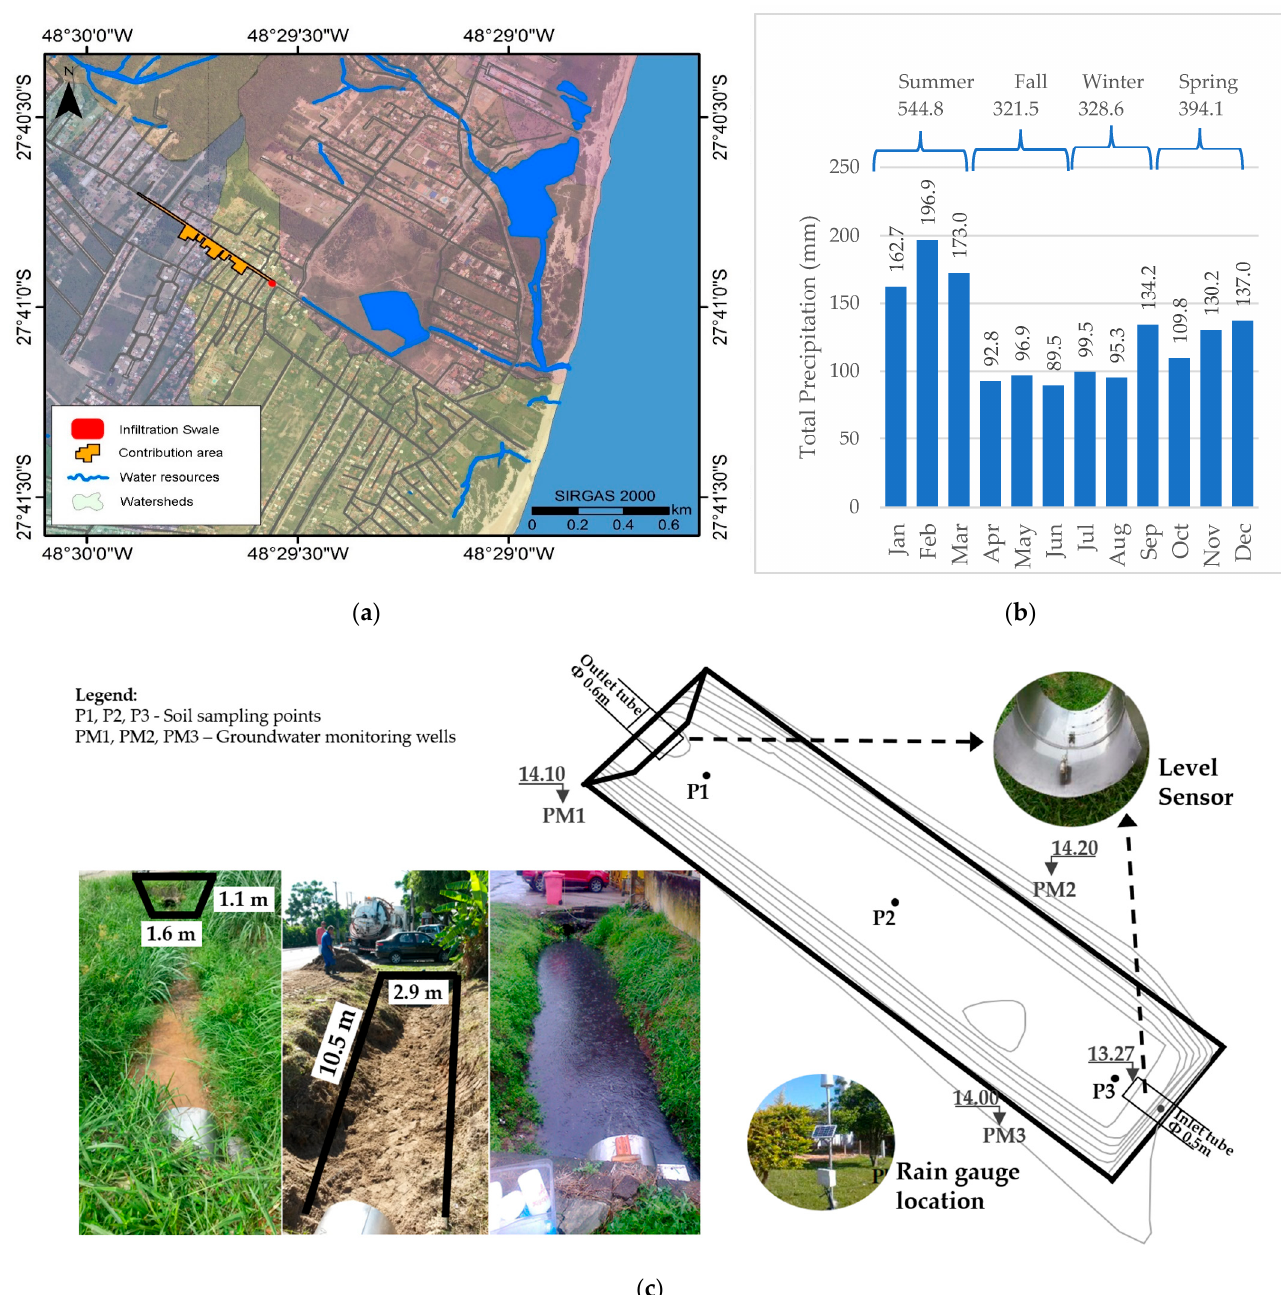
Figure 1. Location and climatological aspects of study area: ( a ) the swale located in Florianópolis in the south of Brazil and its connecting channels to the sea; ( b ) normal climatology of precipitation in Florianópolis (1981–2010) [30] with rainfall depth accumulated by season; and ( c ) swale instrumentation [31].